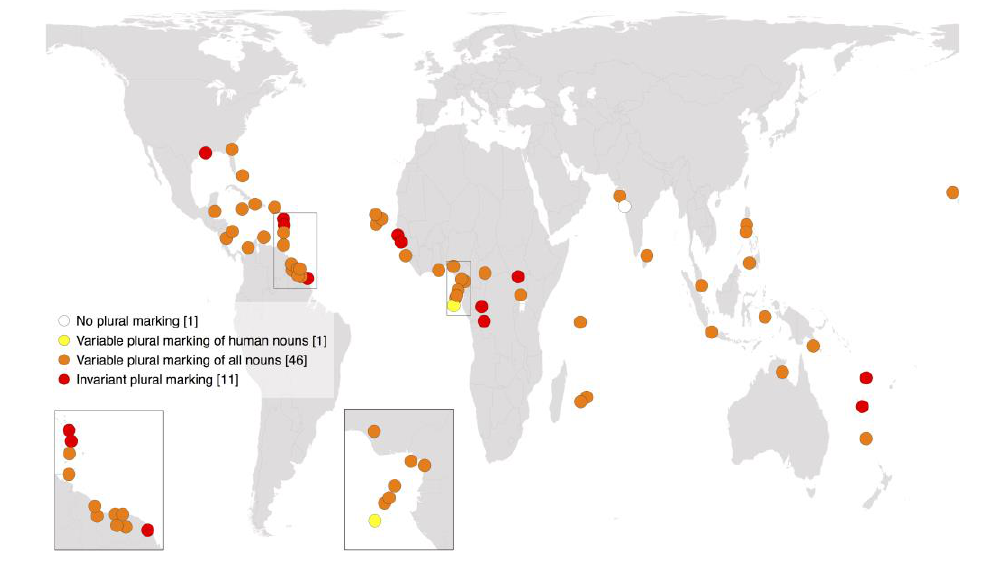
Map 9. Occurrence of nominal plural markers in 59 creoles of